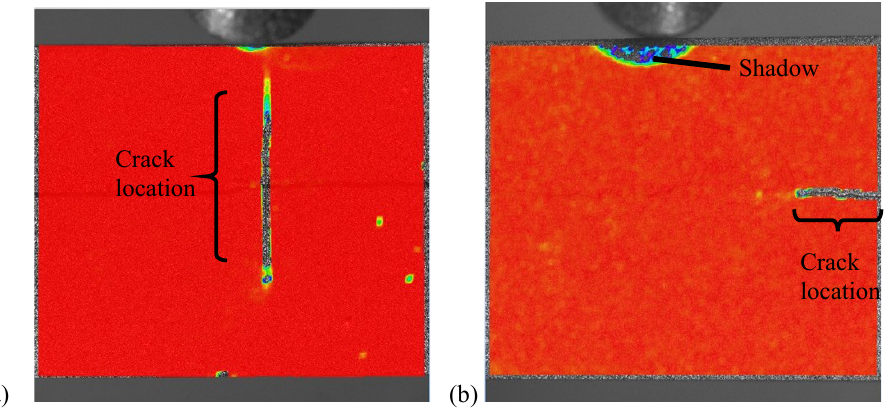
Fig. 5. Map of the DIC correlation coefficient for two specimens displaying the early stages of (a) through thickness and (b) interfacial failure. Cracking interferes with the DIC correlation, allowing crack evolution to be observed. In both cases the influence of the indenter’s shadow causes p oor correlation at the point of